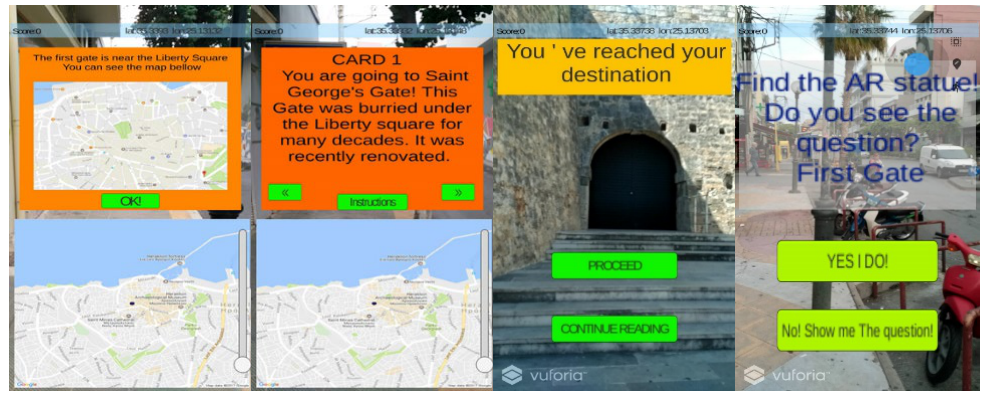
Figure 2. Learning History & Locating the Point of Interest